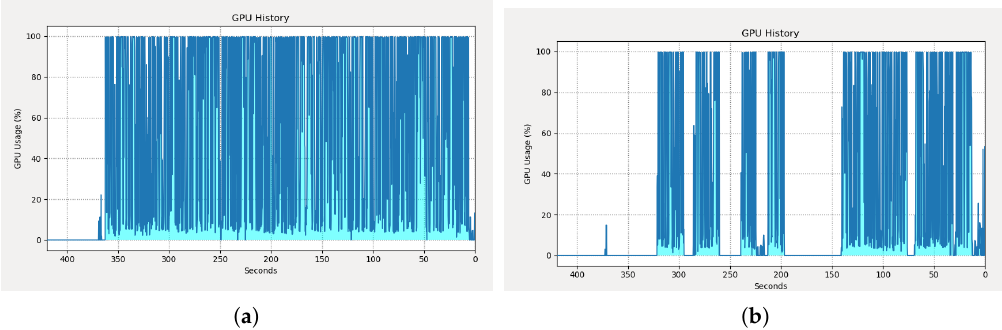
Figure 15. GPU monitoring: ( a ) with the conventional method; ( b ) with the proposed method.